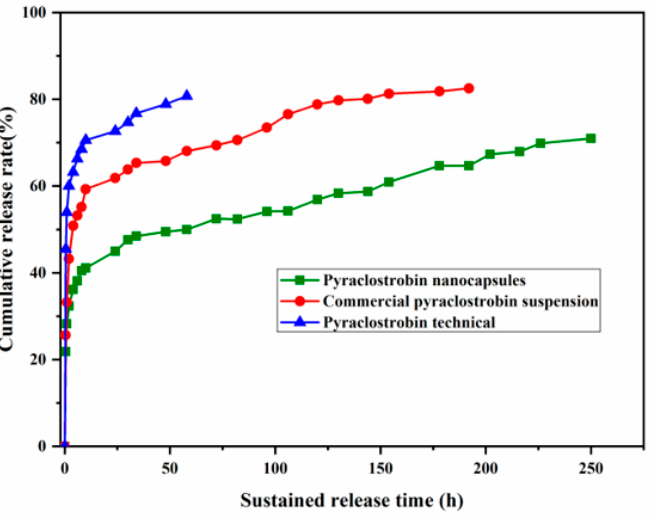
Figure 7. Cumulative release rates of pyraclostrobin nanocapsules, a commercial pyraclostrobin suspension, and technical